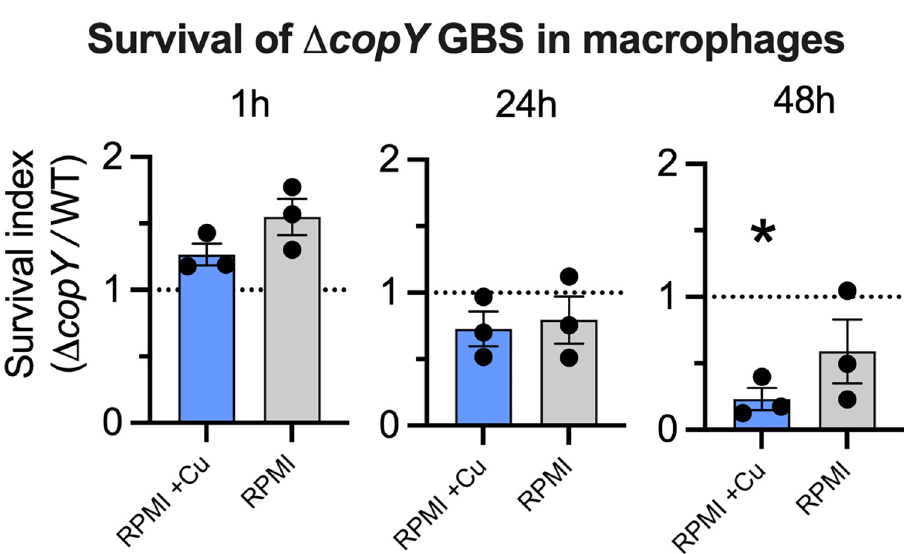
Fig 3. The role of copY in macrophage killing of GBS. Gentamicin protection assays with WT and Δ copY strains in human U937 MDMs in RPMI culture medium supplemented with 20 μ M Cu (Cu-supp; blue bars) and standard RPMI medium (Standard; grey bars). Intracellular survival of Δ copY GBS is shown as a ratio of CFU per milliliter of Δ copY GBS divided by CFU per milliliter of WT GBS (Survival Index). Dotted lines at index = 1 show no difference to WT. Bars show mean ± S.E.M ( n = 3 biological repeats), assays were analysed by One sample t tests against a survival index value of 1 ( � P <